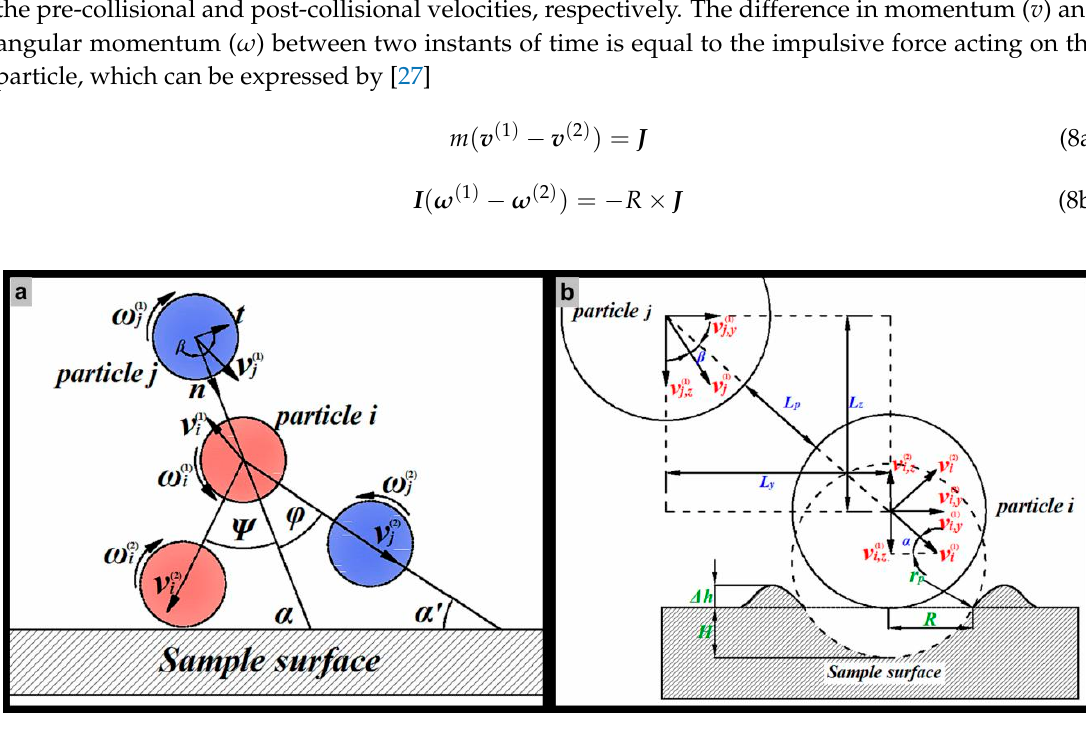
Figure 2. The sketch of impingement between a particle and the wall, ( a ) the particle-particle collision process; ( b ) the particle-wall contact process.